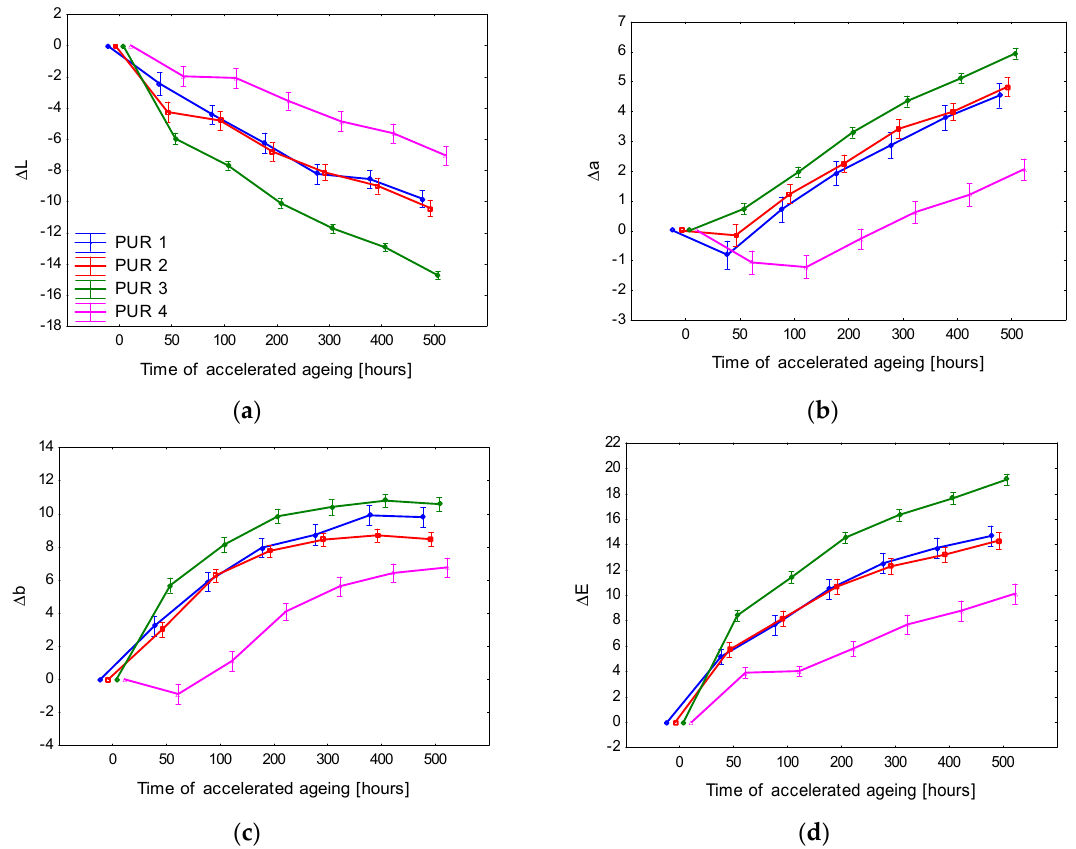
Figure 1. Accelerated-aging-induced differences in colour coordinates ( a ) Δ L* , ( b ) Δ a* , and ( c ) Δ b* , and the total colour difference ( d ) Δ E* of spruce wood surfaces finished with polyurethane lacquers on surfaces without pigment mordants.